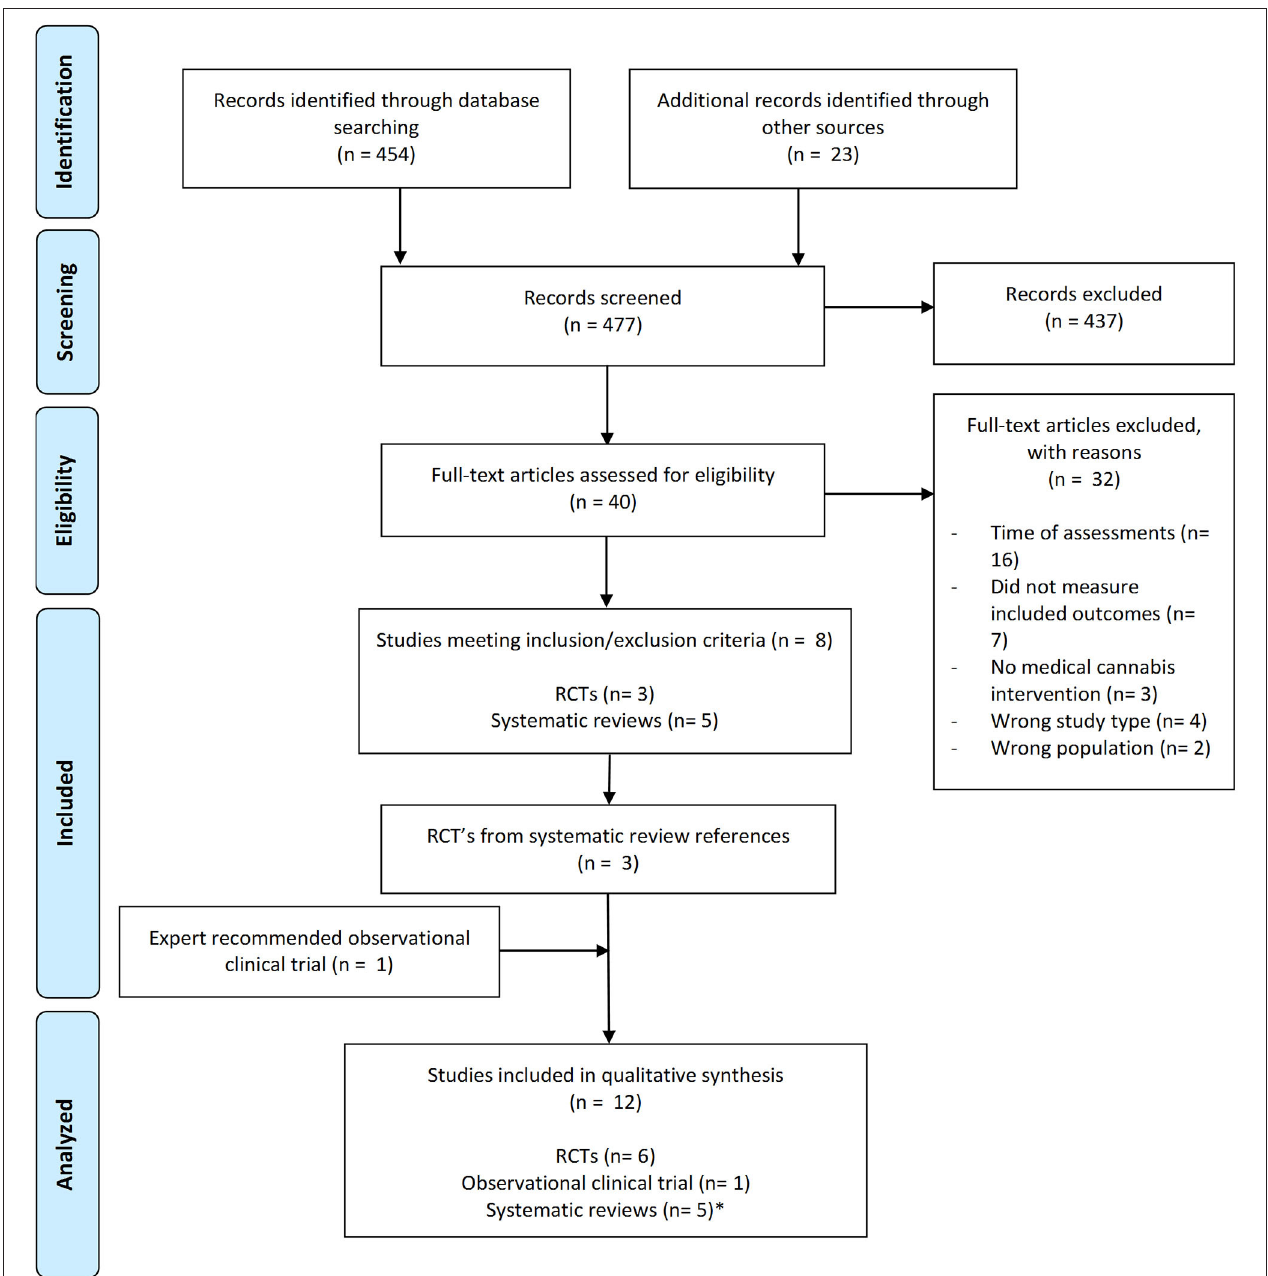
FIGURE 1 | Flow diagram of search strategy and methodology. * Results from systematic reviews were not included in our formal analysis as we were comparing raw data from independent clinical